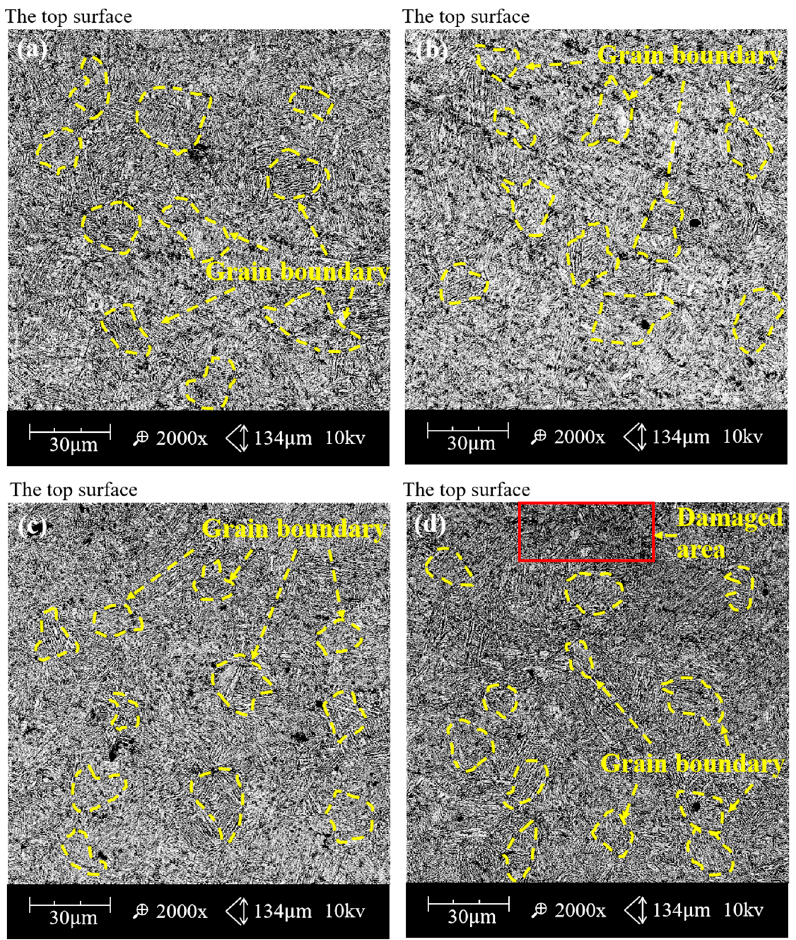
Figure 13. SEM images of the surface layer of specimens at different pulse energies ( a ) 6 J; ( b ) 8 J; ( c ) 10 J; ( d ) 12 J.